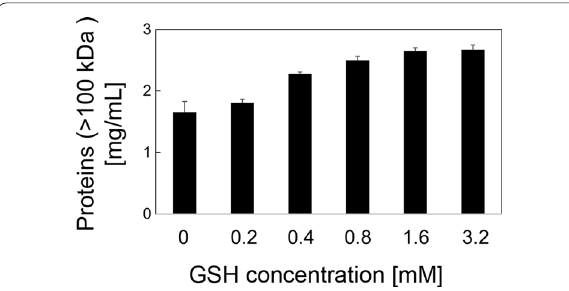
T m S Fig. 3 Sm TG activity measured by the incorporation of MDC into N , N ‑dimethylcasein. 12 Sm TG extracted from BY4741‑TG and × GCI‑TG strains were used for cross‑linking reactions. The values are means and the error bars show the SD ( n 5). Statistically significant = differences are indicated by an asterisk ( p =